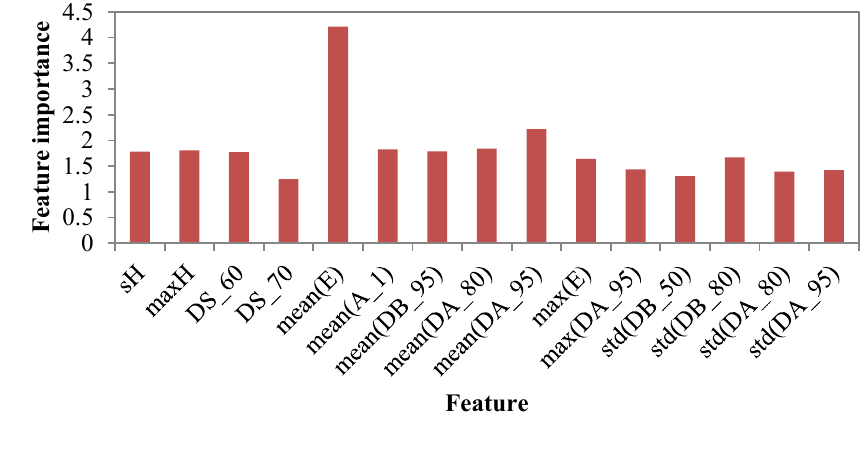
Figure 8. Feature importance for 15 most significant features selected from both DSC and FWF features; the greater the value, the more important the feature.